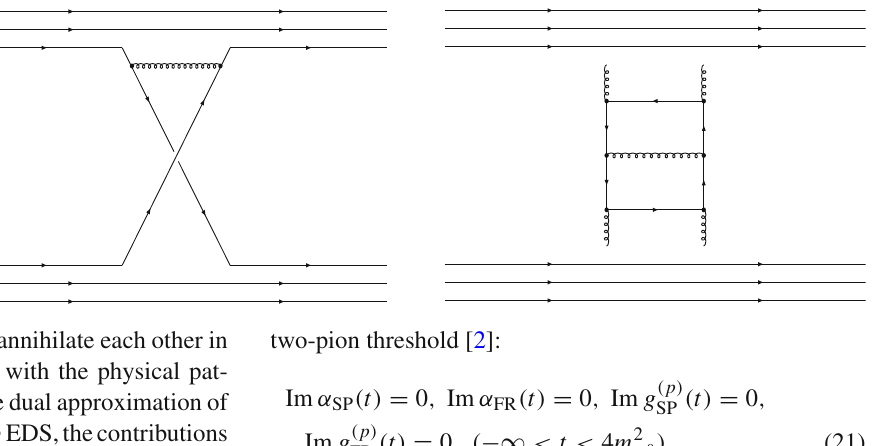
Fig. 2 Two types of the QCD contributions to nucleon–nucleon EDS wherein the meson resonance exchange terms